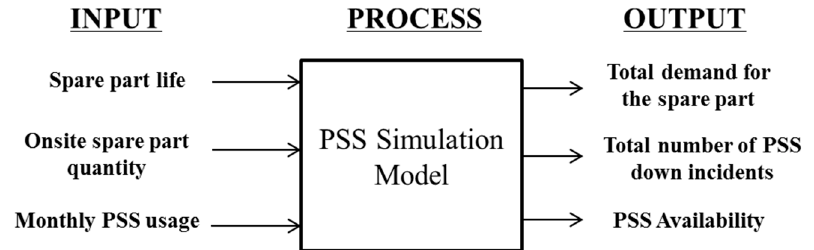
Figure 2. Input-Process-Output (IPO) diagram of the simulation model.